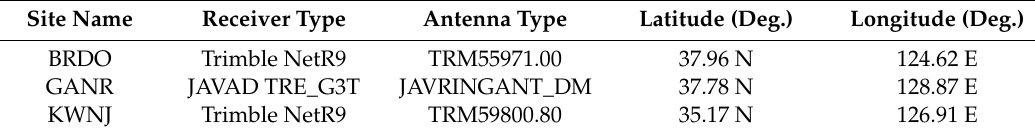
Table 2. The GNSS receiver and antenna types at the three selected stations on the ground.